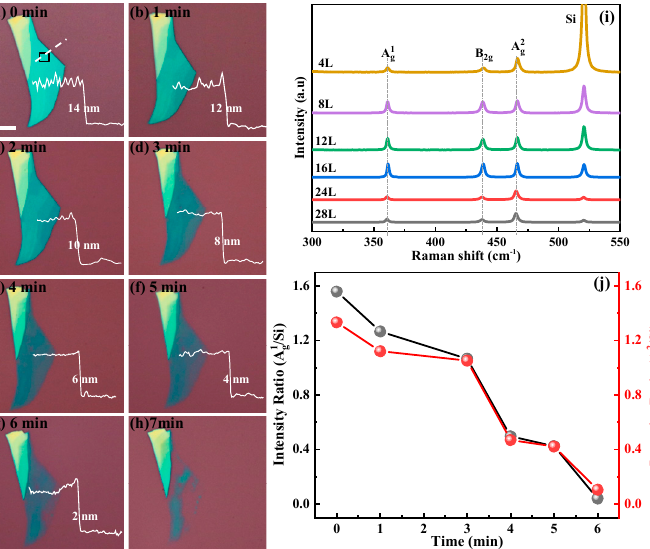
Figure 3. Optical images of mechanically exfoliated BP flakes treated with UV light radiation at different times and 300 °C annealing in N 2 atmosphere ( a – h ). The length of the scale bar is 5 µm. Thinned thicknesses of BP flake as a function of the radiation time are shown as white lines. ( i ) Raman spectra of the BP flake being treated for various UVO light radiation corresponding to ( a – g ). ( j ) Intensity ratio of the A 1g /Si and A 2 g/Si as functions of the UVO light radiation time.